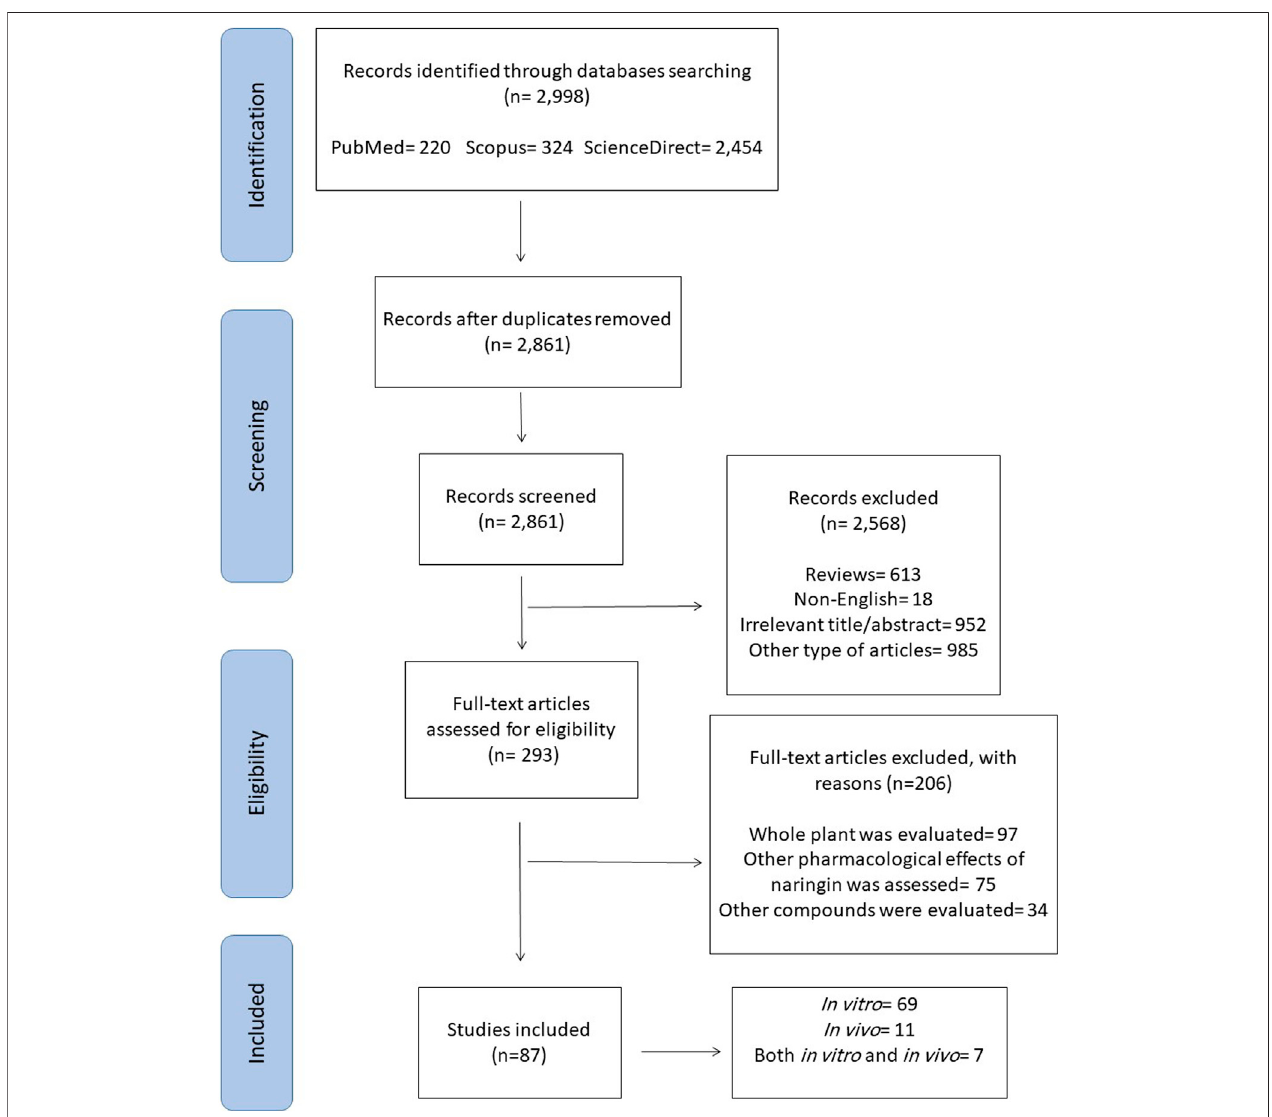
FIGURE 2 | The PRISMA fl ow chart of the selection process for the included studies.